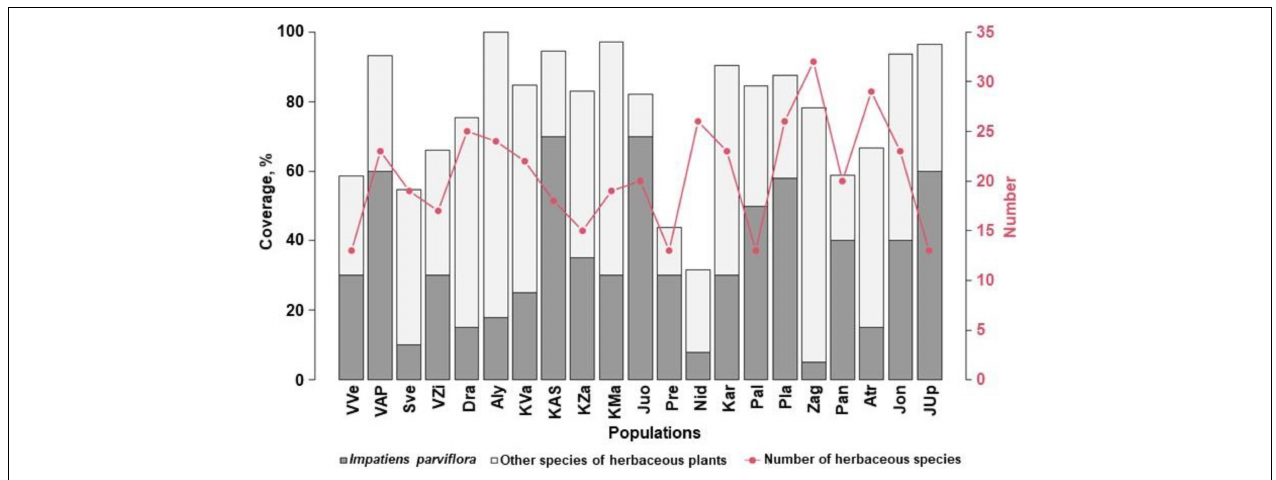
FIGURE 8 | The number of herbaceous species and coverage by Impatiens parviflora and herbaceous plant species in the sites. Three letters denote populations (for details of their locations, see Figure 1 ).